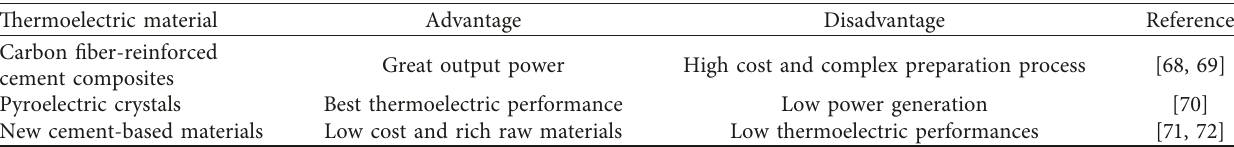
Table 3: Advantages and disadvantages of thermoelectric